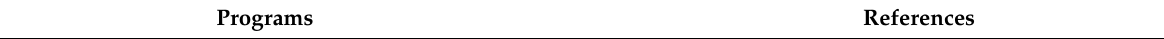
Table 1. Reviewed literature on types of programs in forest therapy studies.